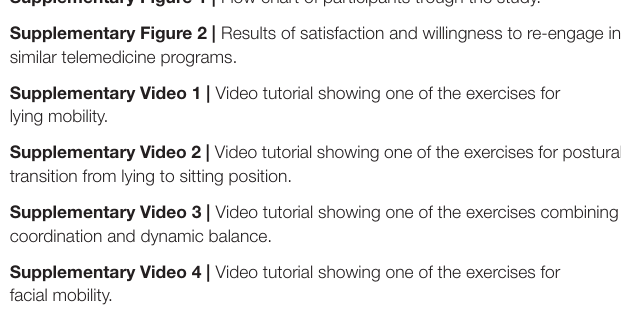
Supplementary Figure 1 | Flow chart of participants trough the study. Supplementary Figure 2 | Results of satisfaction and willingness to re-engage in similar telemedicine programs. Supplementary Video 1 | Video tutorial showing one of the exercises for lying mobility. Supplementary Video 2 | Video tutorial showing one of the exercises for postural transition from lying to sitting position. Supplementary Video 3 | Video tutorial showing one of the exercises combining coordination and dynamic balance. Supplementary Video 4 | Video tutorial showing one of the exercises for facial